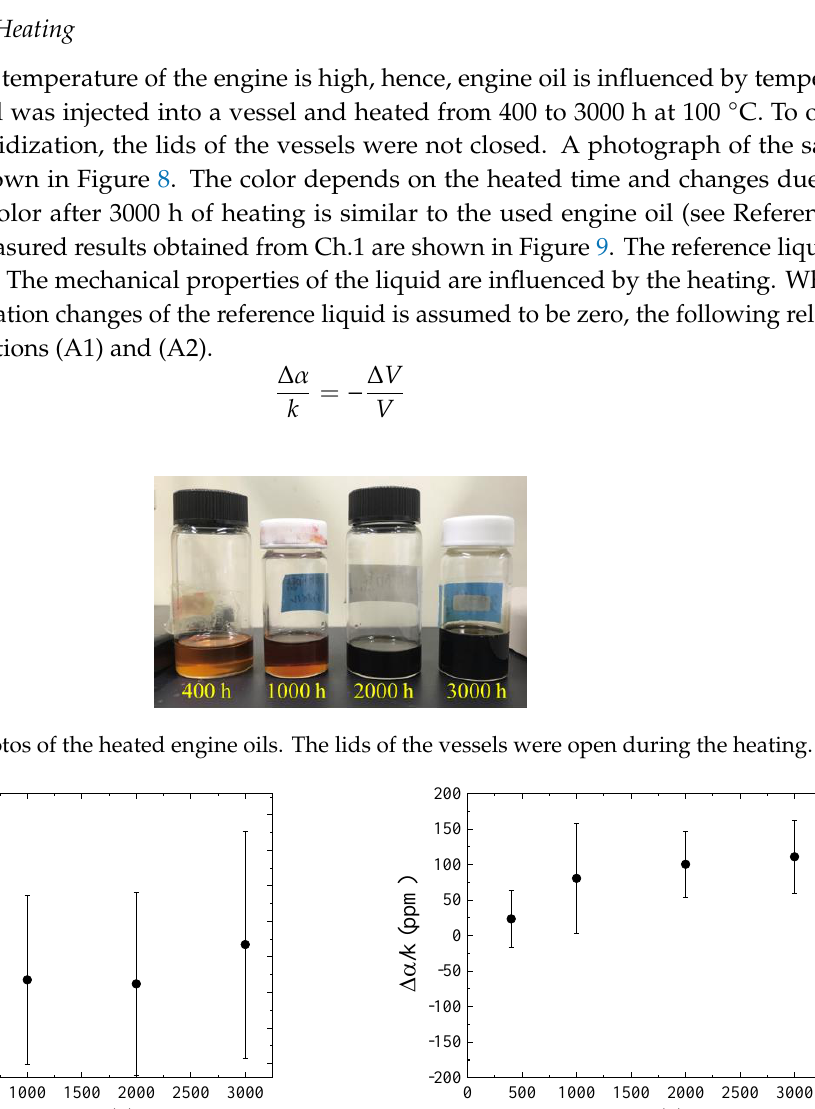
Figure 10. Evaluation of the SH-SAW sensor responses in Figure 9. The solid line shows the Newtonian